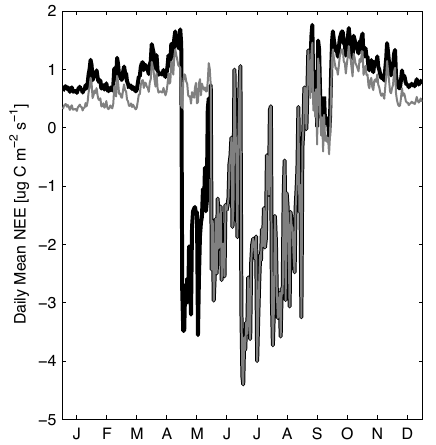
Fig. 17. Difference in the 30–60 ◦ N h CO 2 i bio contrast, averaged over North America (180–300 ◦ W) when fluxes are emitted at two levels in AM2 versus at the surface.